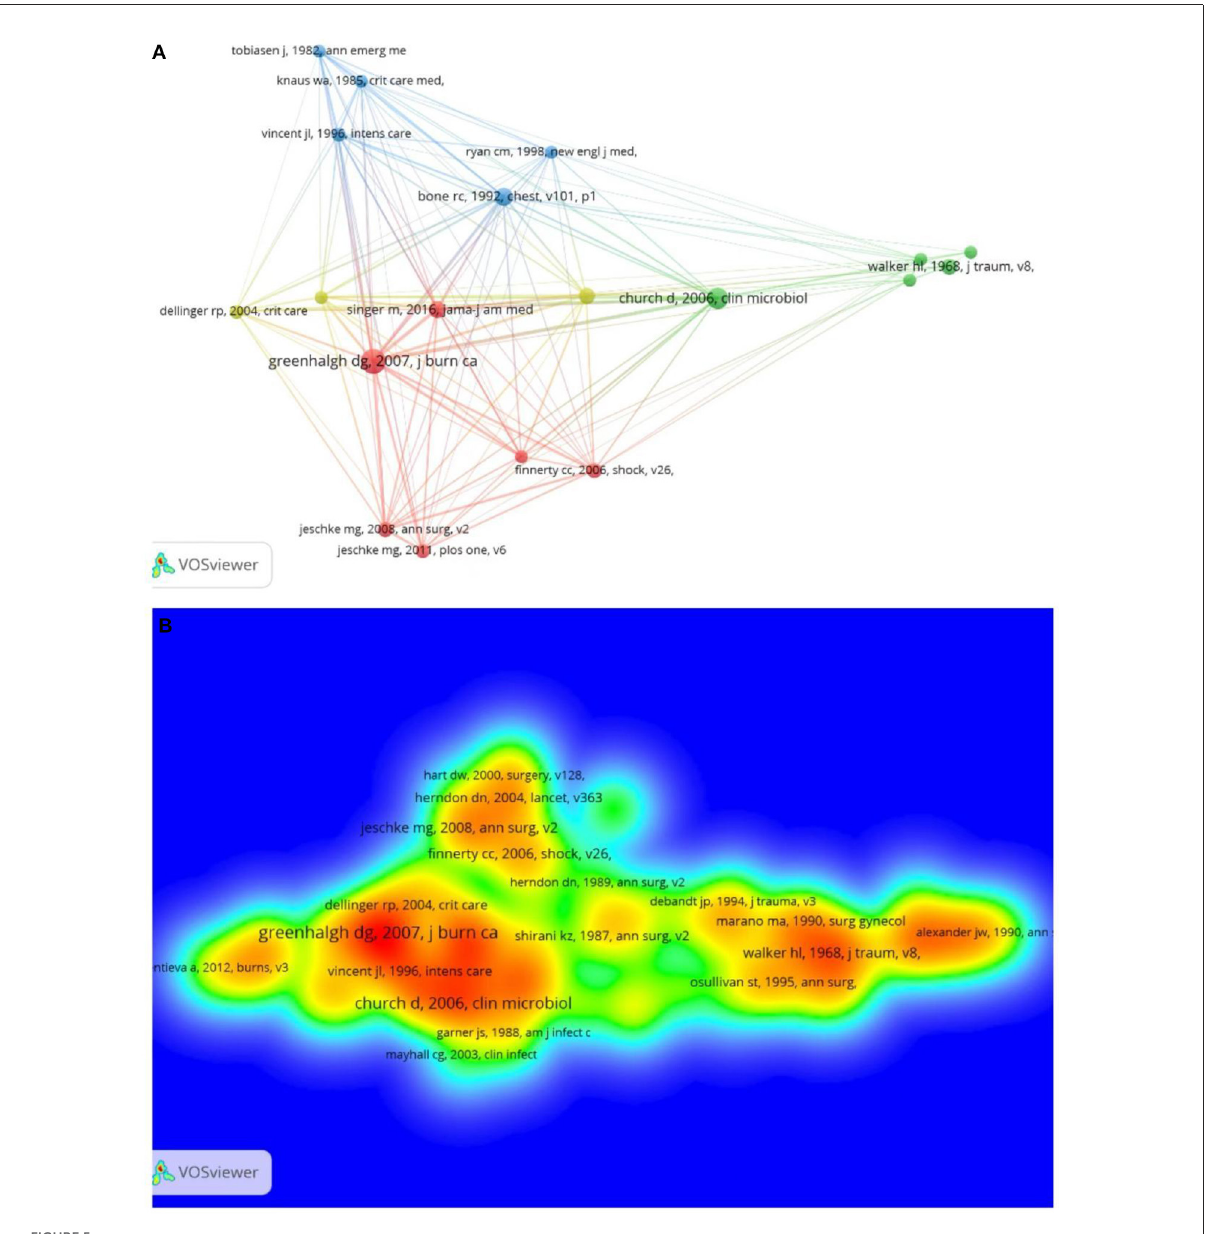
FIGURE5 (A) Analysis of the co-citation network of cited references: the node’s size indicates the frequency of occurrence; the larger the node, the higher the number of references cited. (B) Visual analysis of the density of the cited references: the color represents the density of the cited literature. Red indicates a higher frequency of occurrence, while green indicates a lower frequency of